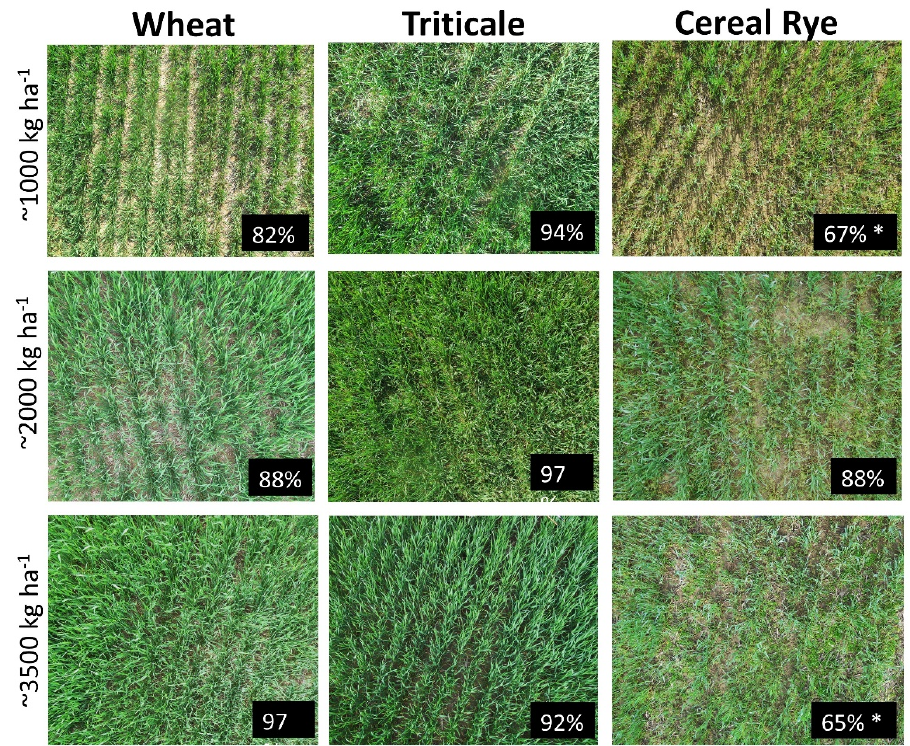
Figure 3. Monopole mounted (~3 m), nadir photographs of crop species at various biomass levels. fractional vegetative cover estimates are displayed in the bottom right corner, and values with ‘*’ indicates a difference in >7 days from when a photograph was collected and when that sample was harvested, dried, and weighed for biomass. Fractional vegetative cover was estimated empirically by applying threshold values for red–green ration and excess green optical vegetation indices.